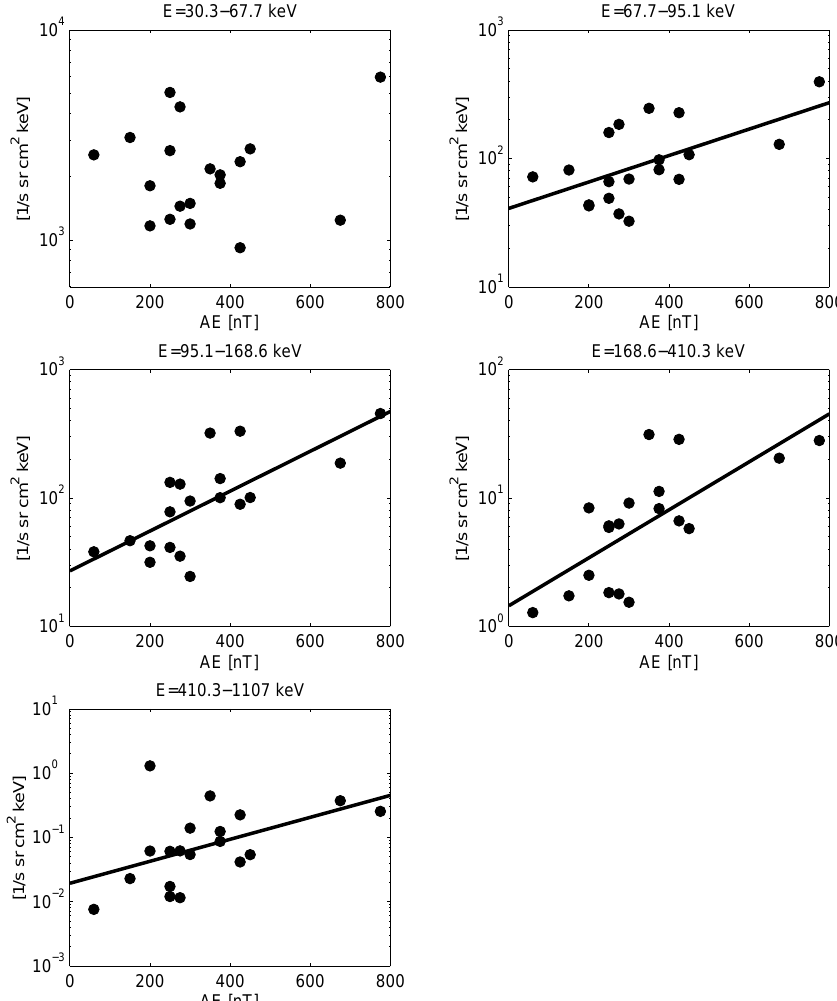
Fig. 9. Differential proton fluxes observed in the exterior cusp at the five lowest energy channels as a function of substorm activity (AE index).